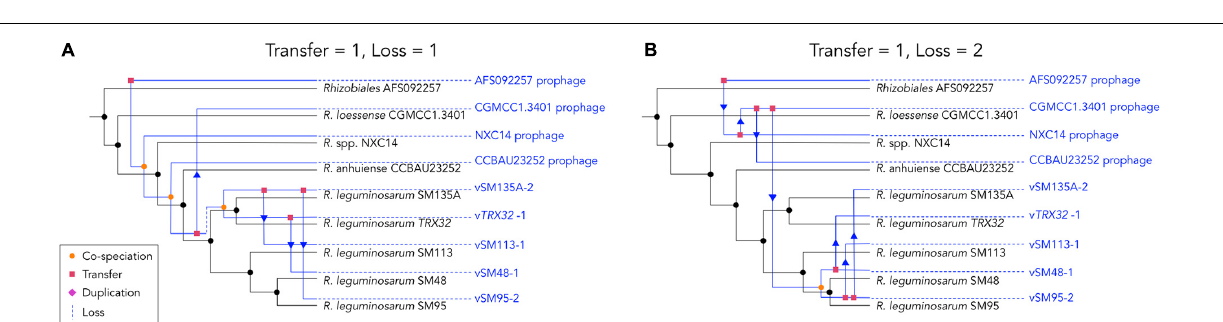
(Zhu et al., 2010; Labrie et al., 2013; Zhao et al., 2013; Hamdi et al., 2016; Kawasaki et al.,